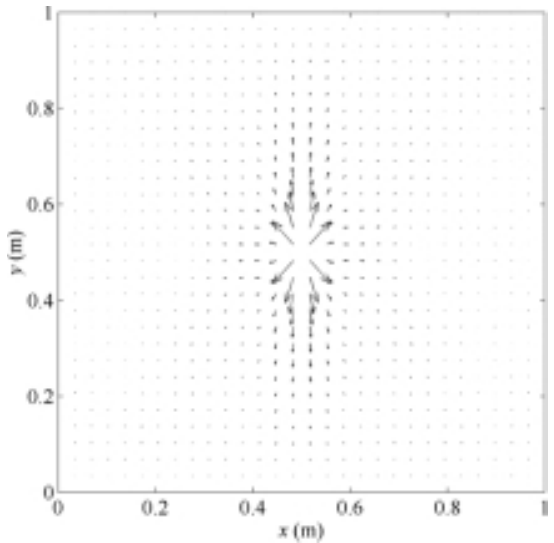
Fig. 9. The classical intensity field in the orthotropic plate when f = 500 Hz and η = 0 . 2 .